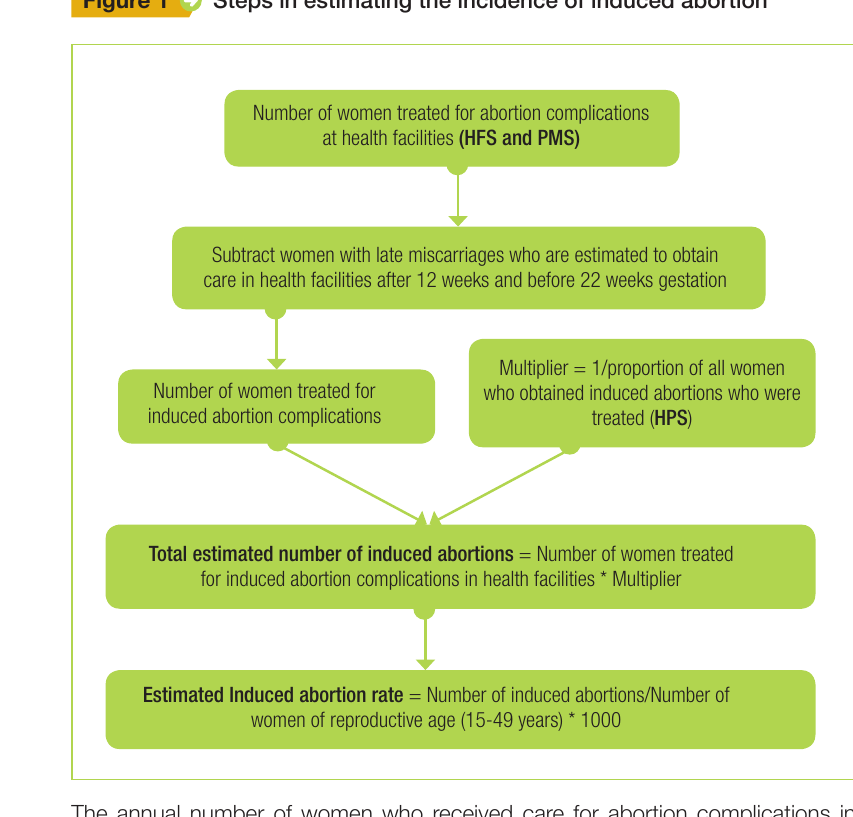
Figure 1 Steps in estimating the incidence of induced